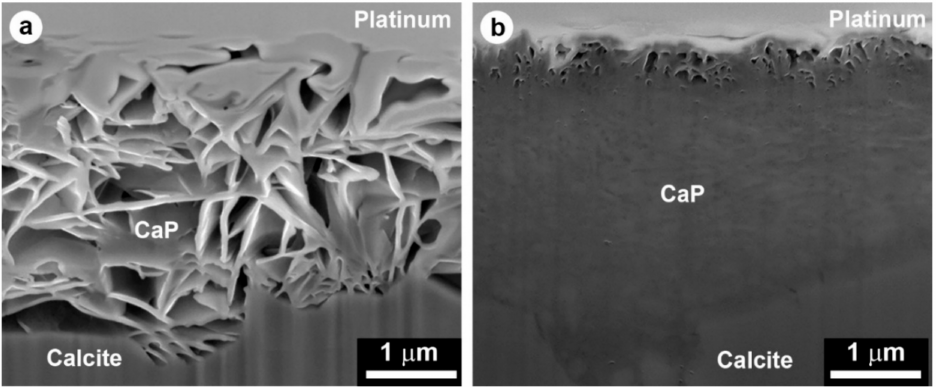
Figure 4. FIB-SEM cross sections of coatings formed by reacting marble for 24 h with